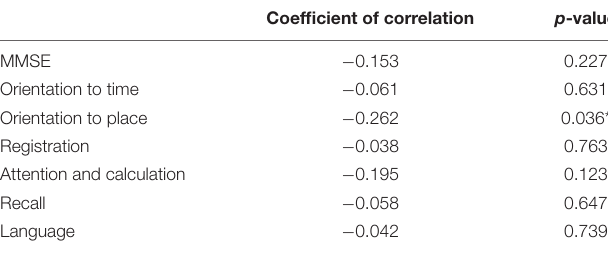
TABLE 6 | the correlation between and NfL and MMSE in total